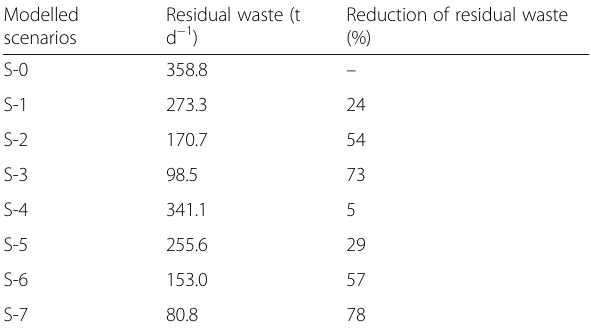
Table 9 Quantity and the reduction of residual waste Modelled scenarios